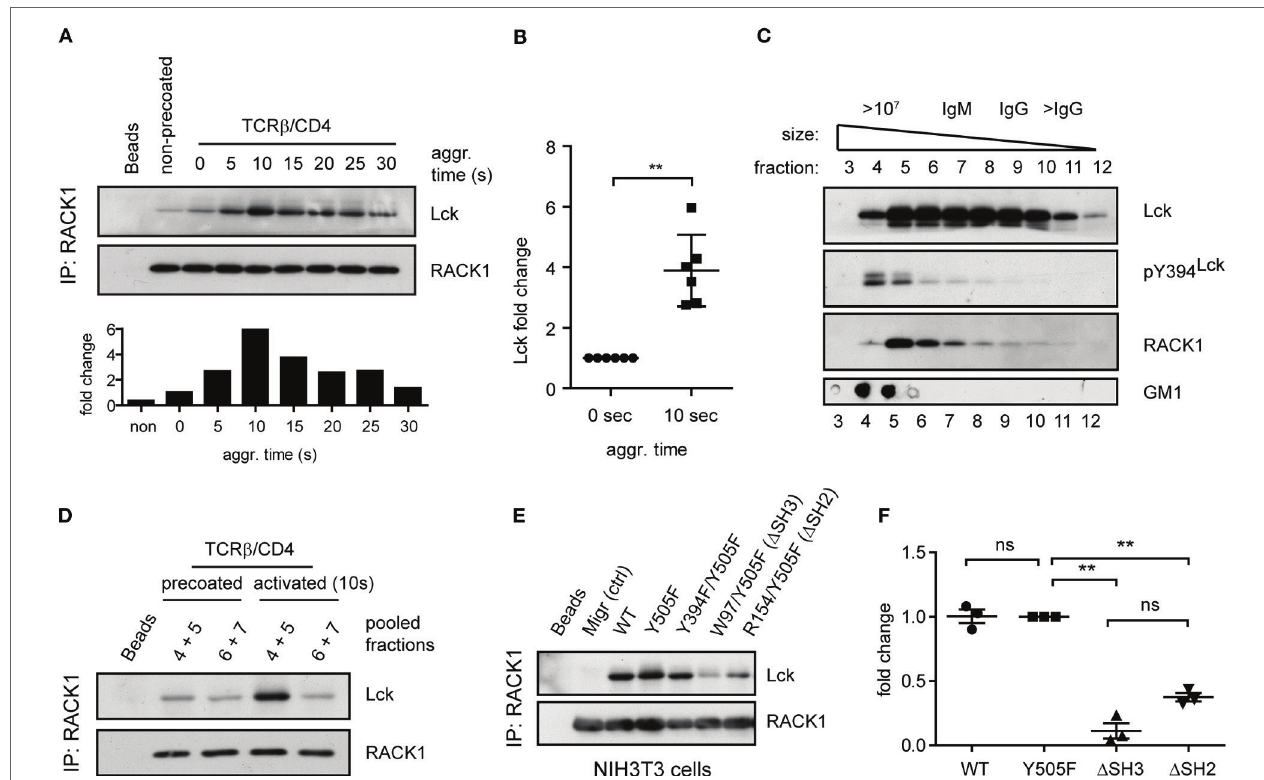
FigUre 4 | antibody-mediated engagement of Tcr/cD4 receptors induces racK1–lck complex formation in primary cD4 + T-cells . (a) CD4 + T-cells precoated or non-precoated with biotinylated anti-TCR and anti-CD4 mAbs (TCR β /CD4) were co-aggregated, or not (0 s), with streptavidin for the indicated time. RACK1 immunoprecipitates were blotted against Lck and RACK1. The bar graph at bottom shows the relative amount of co-immunoprecipitated Lck after normalization to RACK1. (B) The graph plot presents the relative fold increase of co-immunoprecipitated Lck (10 s after activation) from six independent experiments. The statistical analysis presented as mean ± SD was performed using the Student’s two-tailed t -test, ** p < 0.01. (c) RACK1–Lck interaction is localized into HMW fractions. CD4 + T-cells fractions (#3–12) obtained from a Sephadex column were probed with anti-Lck, anti-pY394 Lck , anti-RACK1, and cholera toxin B subunit–HRP, which detects the surrogate marker of light DRMs, GM1. The fraction elution profile of the molecular weight size marker is shown on the top. (D) Fractions #4–5 and #6–7 from non-activated (precoated) or activated (TCR β /CD4, 10 s) CD4 + T-cells were pooled, immunoprecipitated with anti-RACK1, and blotted with anti-Lck and RACK1 antibody. (e) RACK1–Lck interaction depends on functional SH2 and SH3 Lck domains. Endogenously expressed RACK1 was immunoprecipitated from NIH3T3 Lck infectants and blotted with anti-Lck and anti-RACK1 antibodies. (F) Statistical analysis of (e) represents the relative fold-change of RACK1 co-immunoprecipitated Lck variants from three independent experiments. The statistical analysis presented as mean ± SD was performed using the Student’s two-tailed t -test, ** p < 0.01, n.s., not significant. Blots shown in (c–e) are representatives of at least three independent